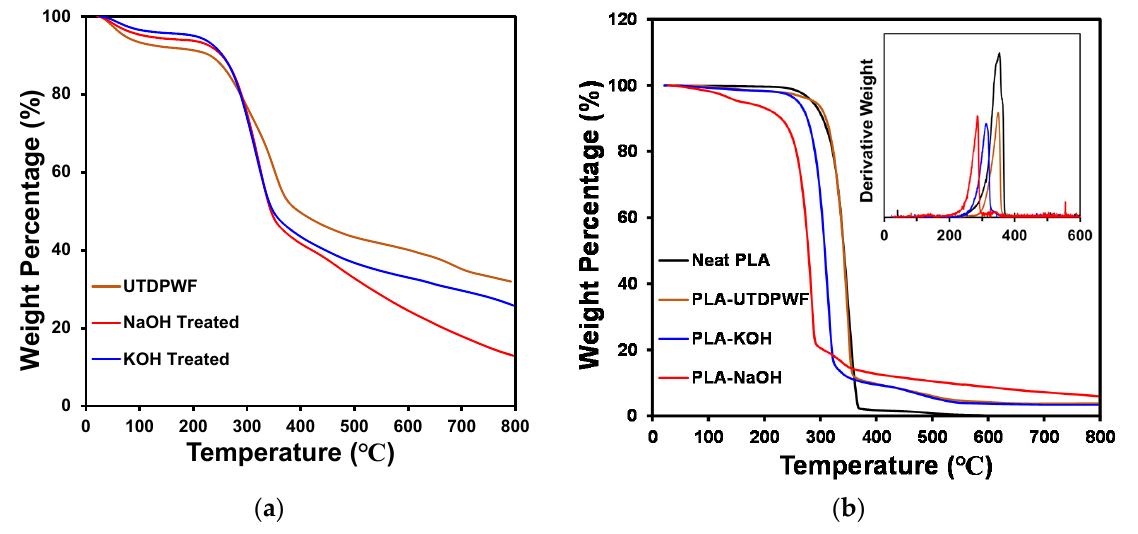
Figure 8. ( a ) TGA for UTDPWF, NaOH treated, and KOH treated; ( b ) TGA and DTG for PLA, PLA-UTDPWF, PLA-NaOH, and PLA-KOH